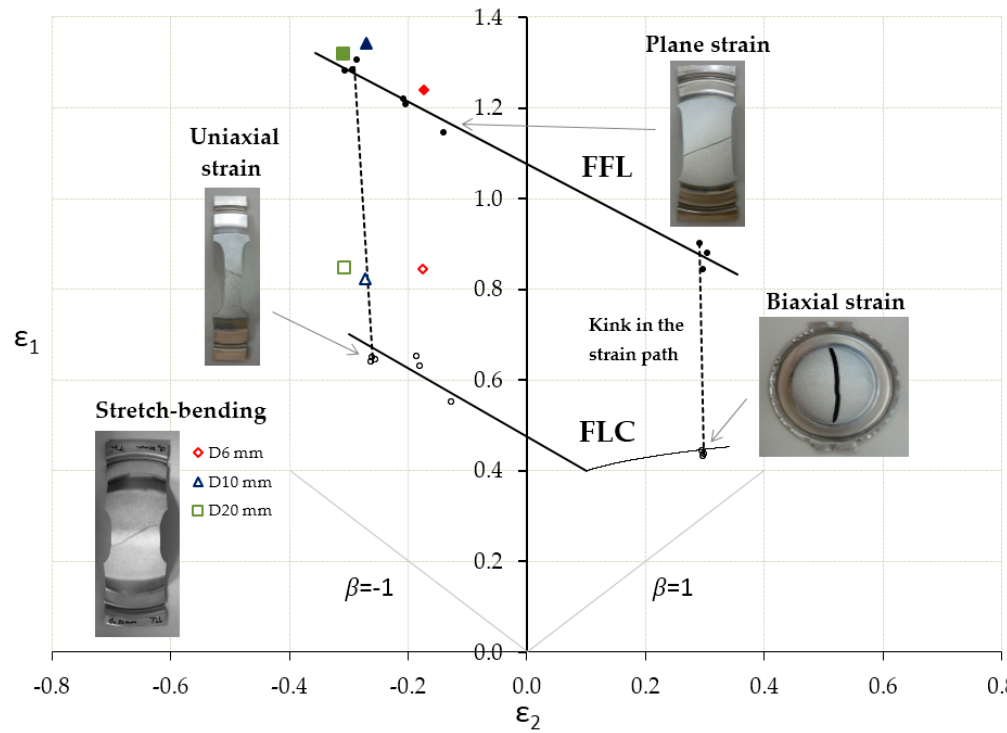
Figure 2. FLD of AISI 304-H111 sheets including bending effects.